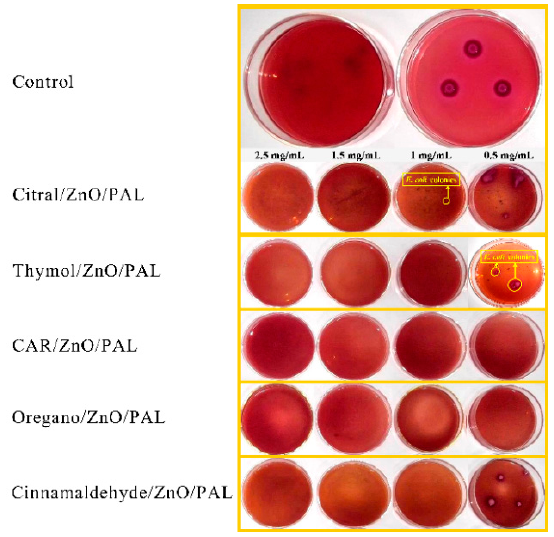
Figure 8. MIC value of PEOs/ZnO/PAL nanocomposites against E. coli .